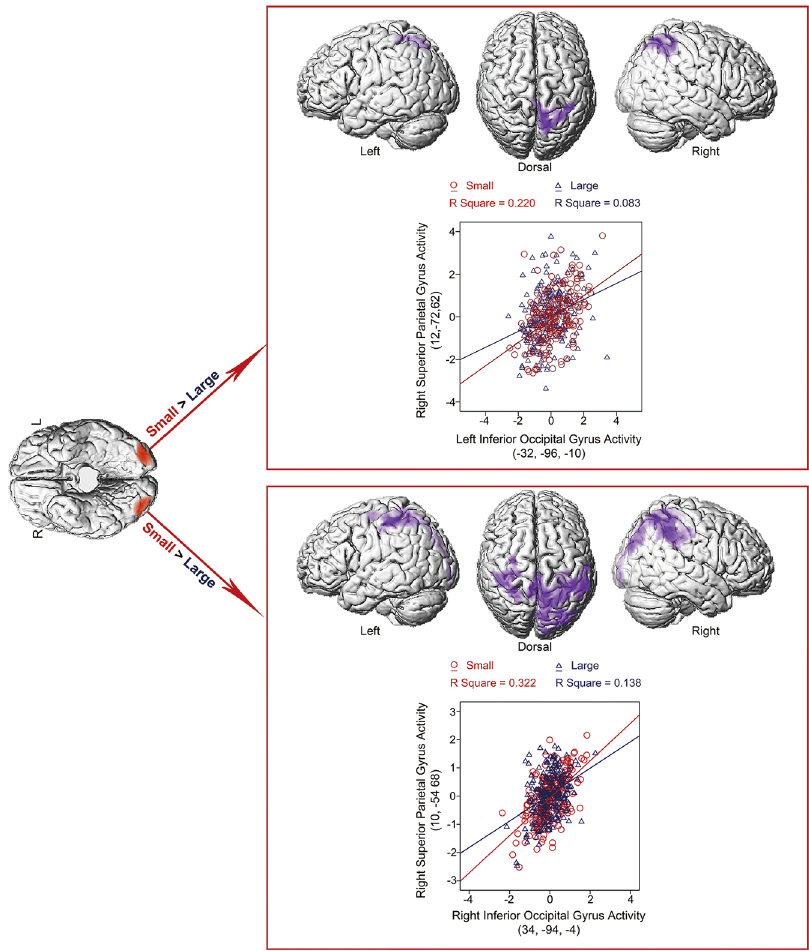
Figure 2. PPI analysis based on neural activity in bilateral IOG (dark red) with the “Small > Large” contrast as the psychological factor in the 2D experiment. The right upper panel: the left IOG showed higher neural coupling with the right SPC in the “Small” condition than in the “Large” condition. PPI analysis based on neural activity in the left middle occipital gyrus of an individual subject (Subject 2D_S24) is shown. Mean corrected neural activity in the right SPC was plotted as a function of the mean corrected neural activity in the left IOG in the “Small” and “Large” conditions, respectively. The right IOG showed higher neural coupling with bilateral SPC in the “Small” condition than in the “Large” condition. PPI analysis based on neural activity in the right IOG (Subject 2D_S24) was shown. Mean corrected neural activity in bilateral SPC was plotted as a function of the mean corrected neural activity in the left IOG in the “Small” and “Large” conditions,